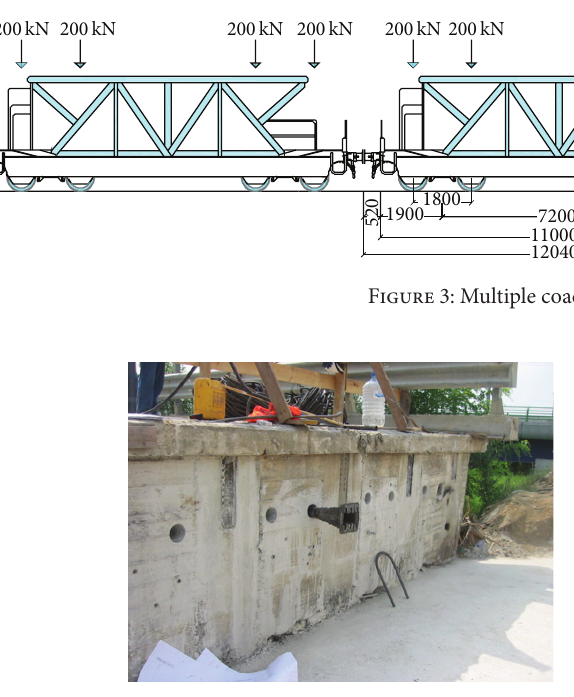
Figure 4: Anchor heads and antispalling